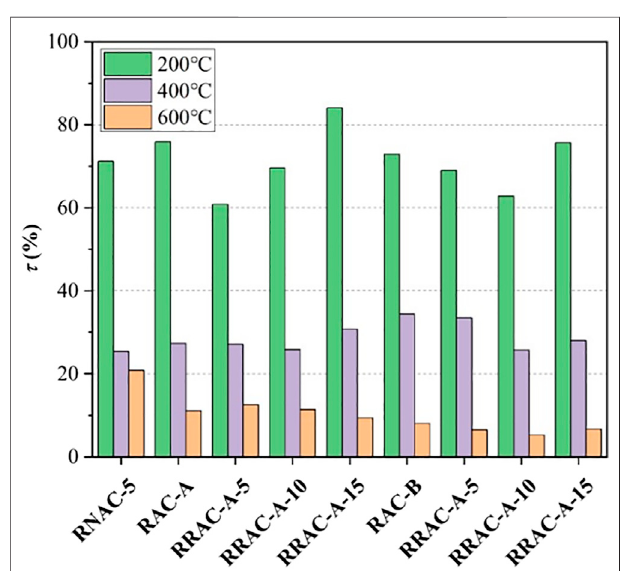
FIGURE 11 | Loss of elastic modulus for RNAC and